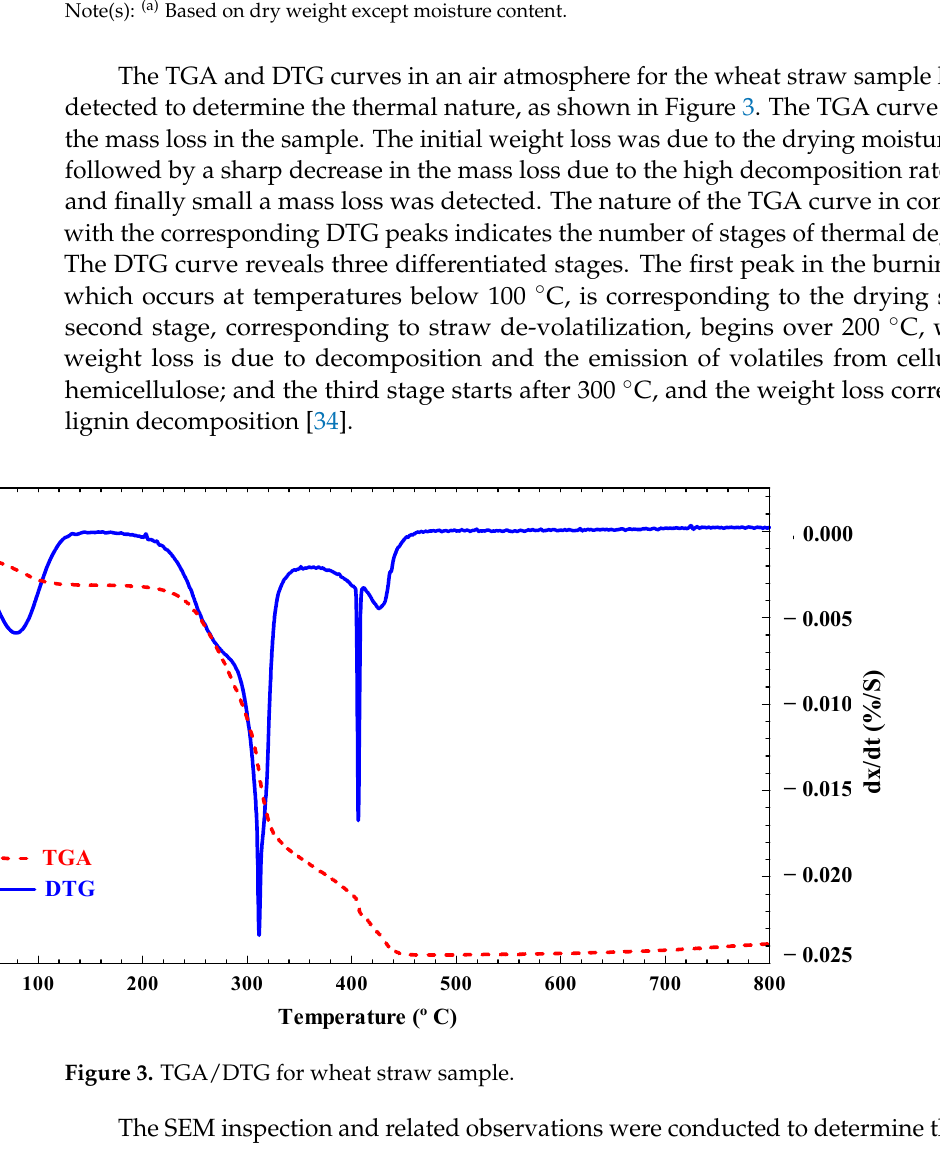
Figure 4. The SEM inspection for wheat straw sample at 500 µm and larger magnification at 100 µm. 3.2. Characteristics of Activated Carbons Table 3 shows the textural and chemical characteristics of the used carbons ACWS and CACC. Both the ACWS and CACC carbons have a large surface area (1164 and 951 m 2 /g, respectively) and large micro-pore volumes (W0) obtained by N 2 adsorption (0.51 and 0.37 cm 3 /g, respectively) and by CO 2 adsorption (0.48 and 0.22 cm 3 /g, respectively). However, the ACWS has a higher surface area and larger micro-pore volume compared to the CACC. The pH of point of zero charge was 5.99 and 4.70 for carbons ACWS and